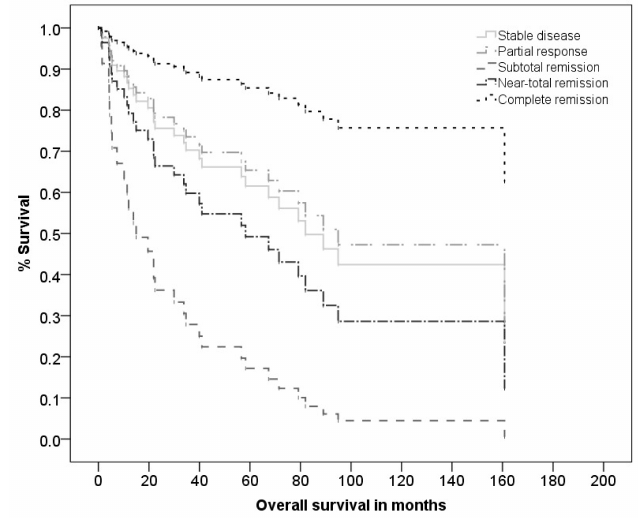
Figure 5. Kaplan–Meier curve of overall survival according to the histopathological response.